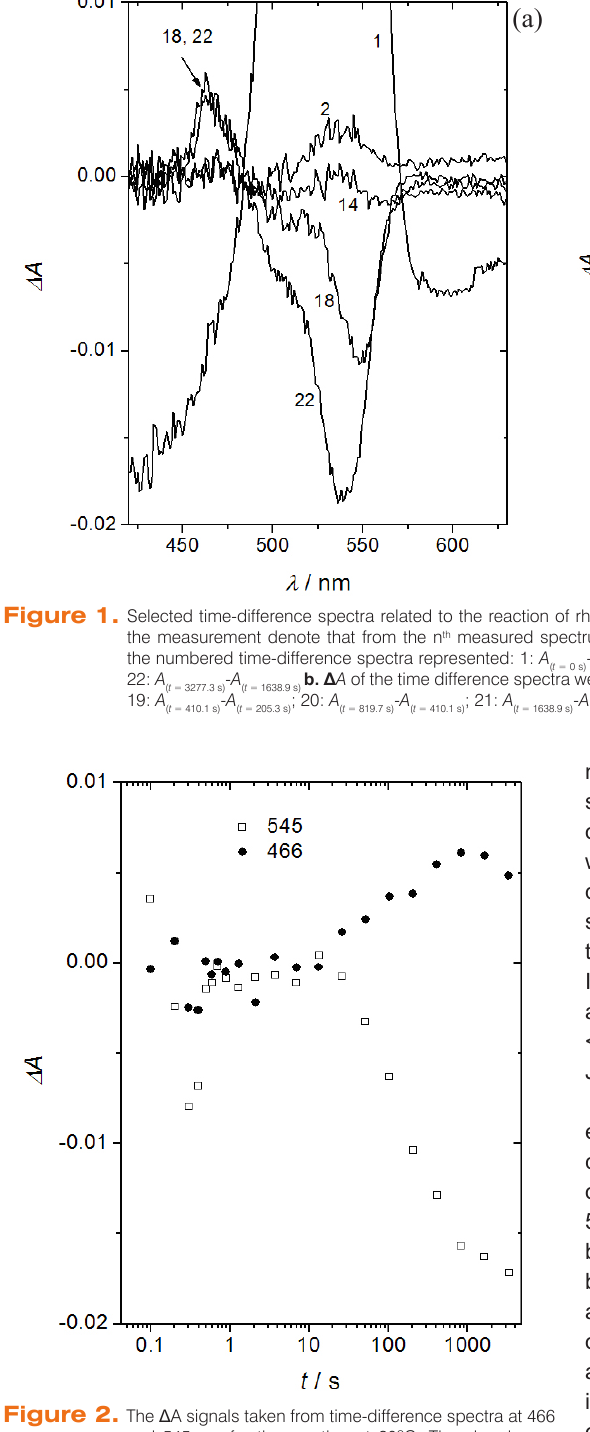
Figure 2. The Δ A signals taken from time-difference spectra at 466 and 545 nm for the reaction at 20ºC. The absorbance changes after about 10 s denote the start of the second stage of the reaction. (Until 0.7 s, cycle time was 0.1 s, and then the cycle time increment was increased by 100%: 0.6, 0.7, 0.9, 1.3, 2.1, 3.7, 6.9